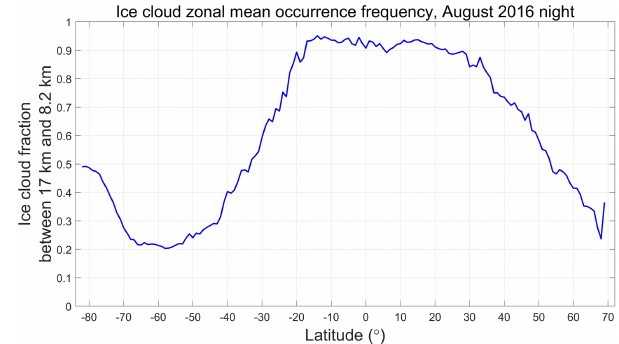
Figure 3. Latitudinally varying fraction of ice cloud range bins in Fig. 2 that lie within the V3 calibration cloud search